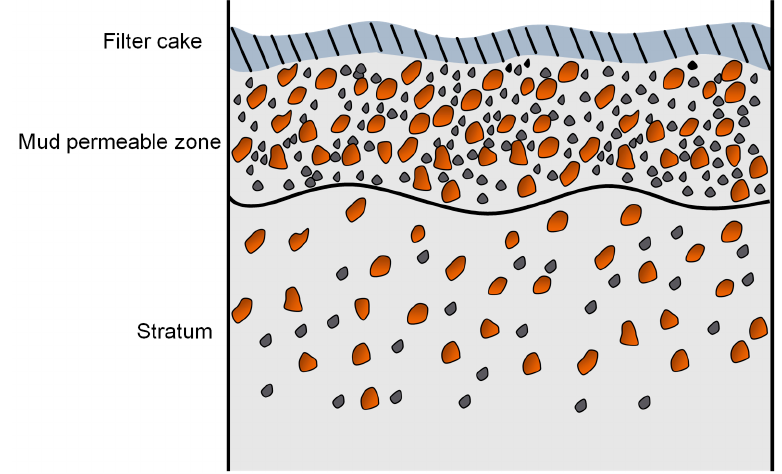
Figure 3. Morphology of filter cake (not in scale).